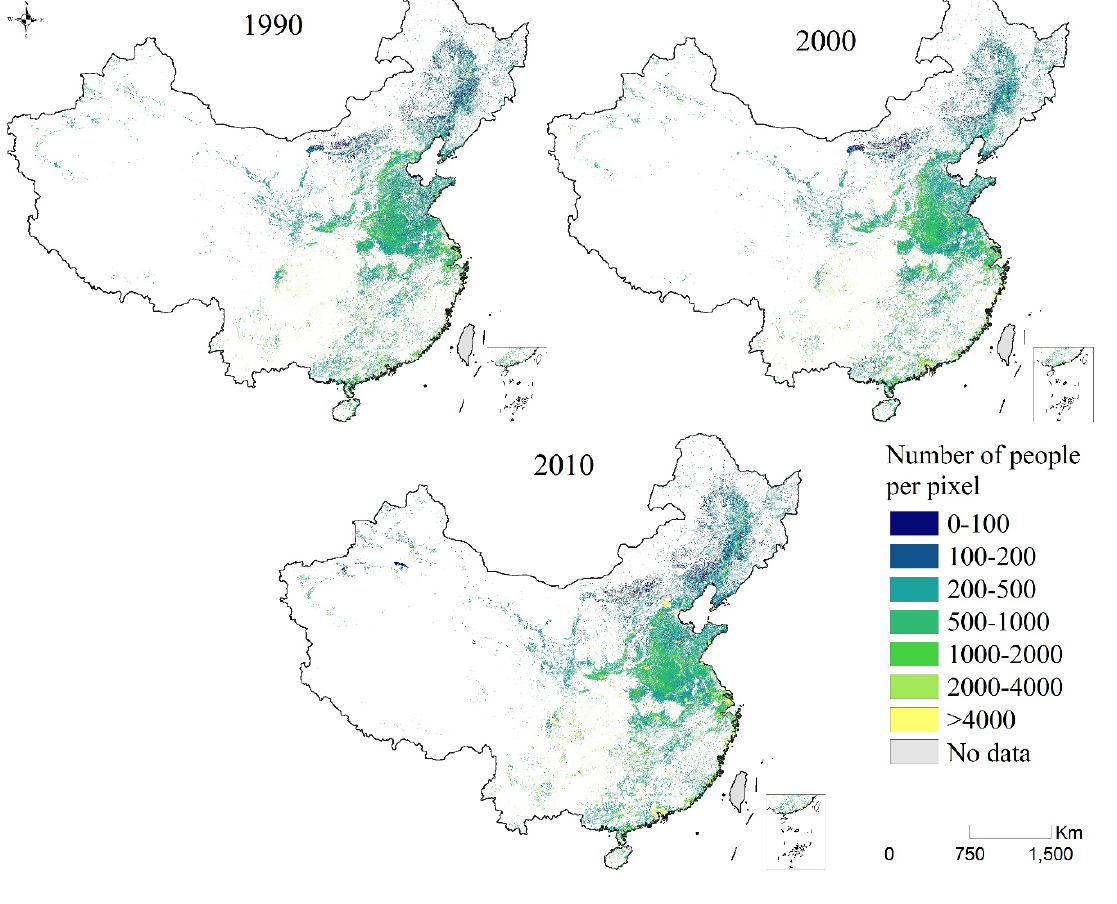
Figure 4. Population density maps with a 1 km × 1 km grid in